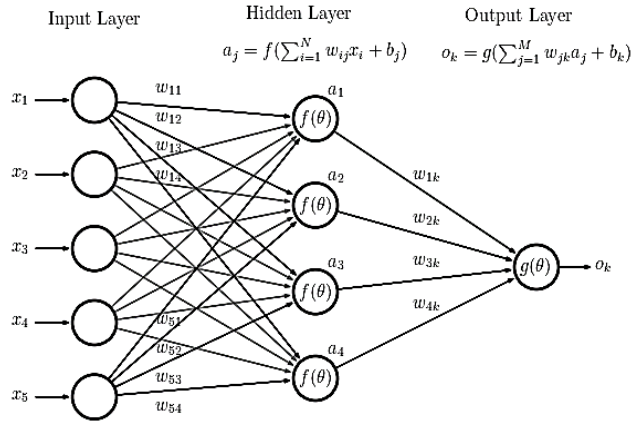
Figure 1. A basic example of a neural network structure (source: www.astroml.org, accessed on 27 May 2021).